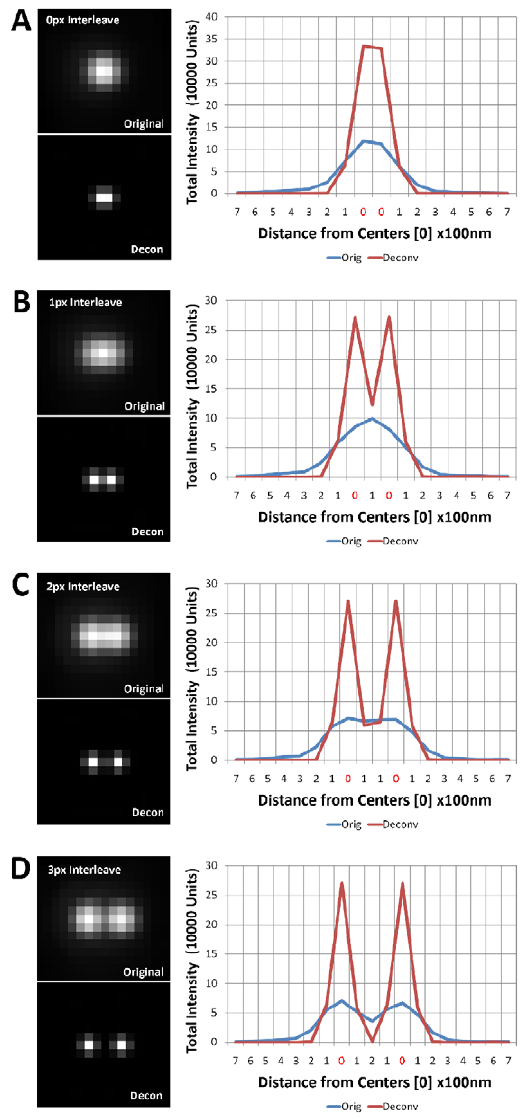
Figure 3. Deconvolution improves the resolvability of adjacent point sources. Here we plot the central cross-sectional profiles of an empirically measured point source, duplicated to simulate two adjoining point sources. Through the linear addition of intensity profiles after the two point sources were shifted in space, we demonstrate the improved resolution of the point sources after deconvolution. Note: 0 along the x axis denotes the center of the two point sources. (A) The centers are shifted by 1 pixel (100 nm) apart, and predictability one cannot resolve the two points in either case, because the centers occupy adjacent pixels. (B) The centers are shifted by 2 pixels (200 nm) apart, and now clearly the deconvolved point sources are resolvable. (C) The centers are shifted by 3 pixels (300 nm) apart. The situation is not different from the 2pixel shift. (D) The centers are shifted by 4 pixels (400 nm), and finally, the non-deconvolved point sources are resolvable. Thus, deconvolution decreases the threshold of resolvability for 4 pixel shift to 2 pixel